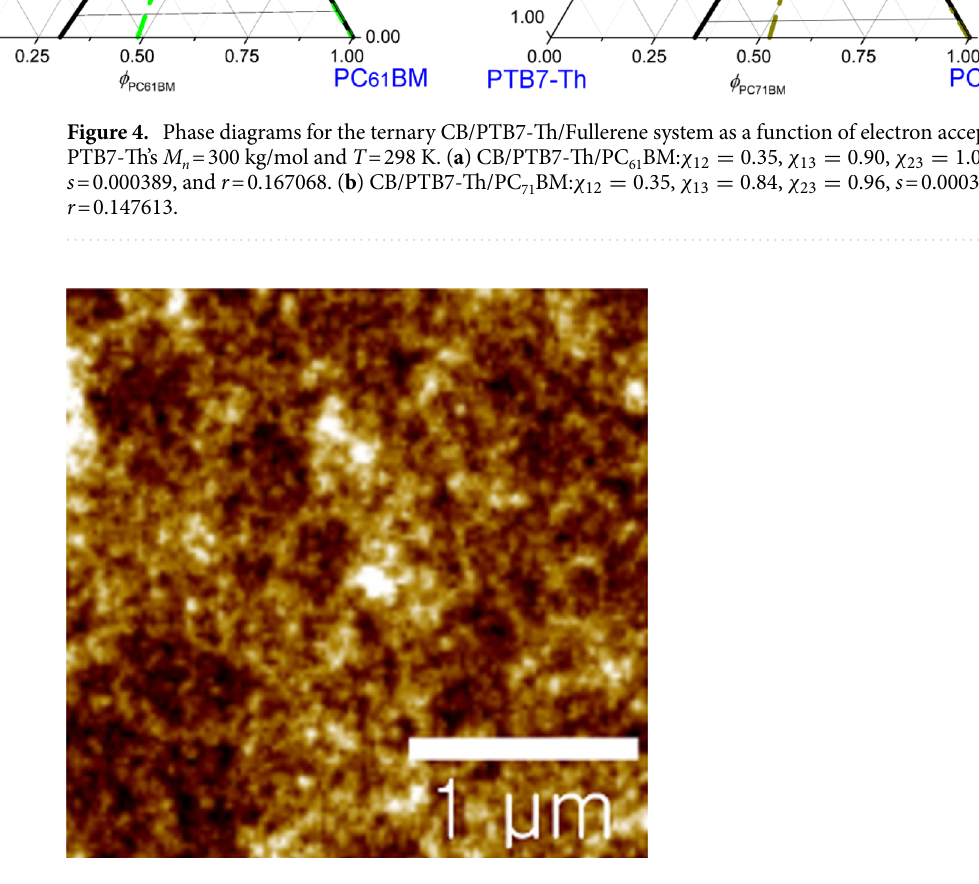
Figure 5. Tapping mode AFM height images of a pure PTB7-Th